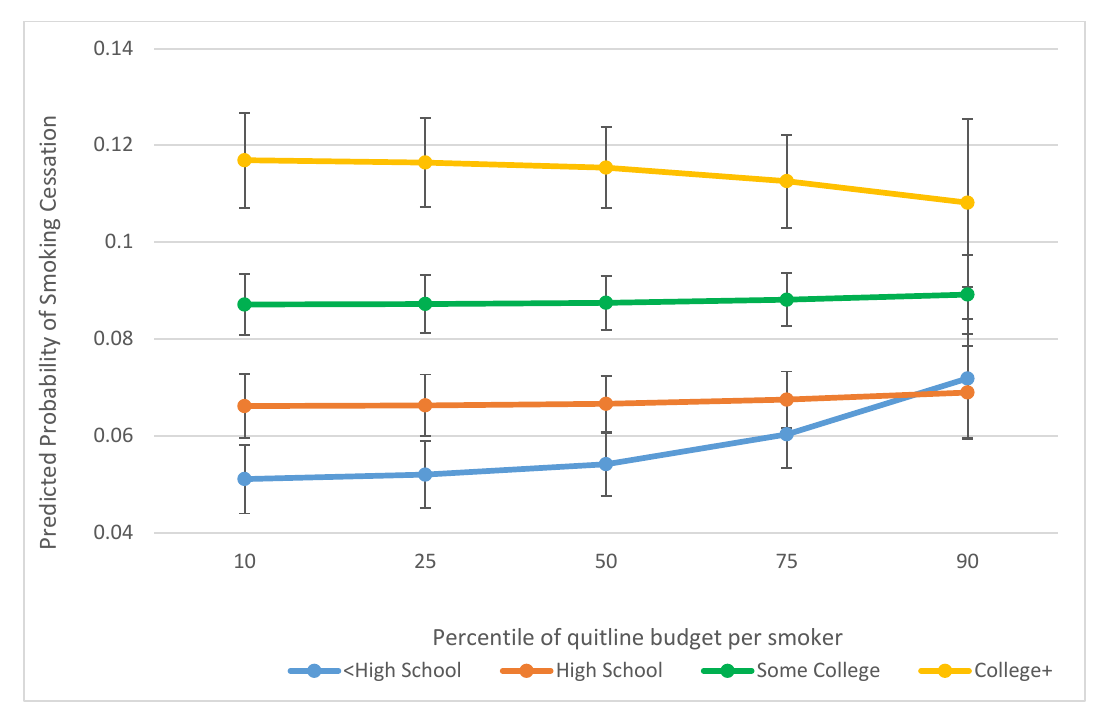
Figure 2. Predicted probability of 90-day smoking cessation associated with quitline budget per smoker, by education.